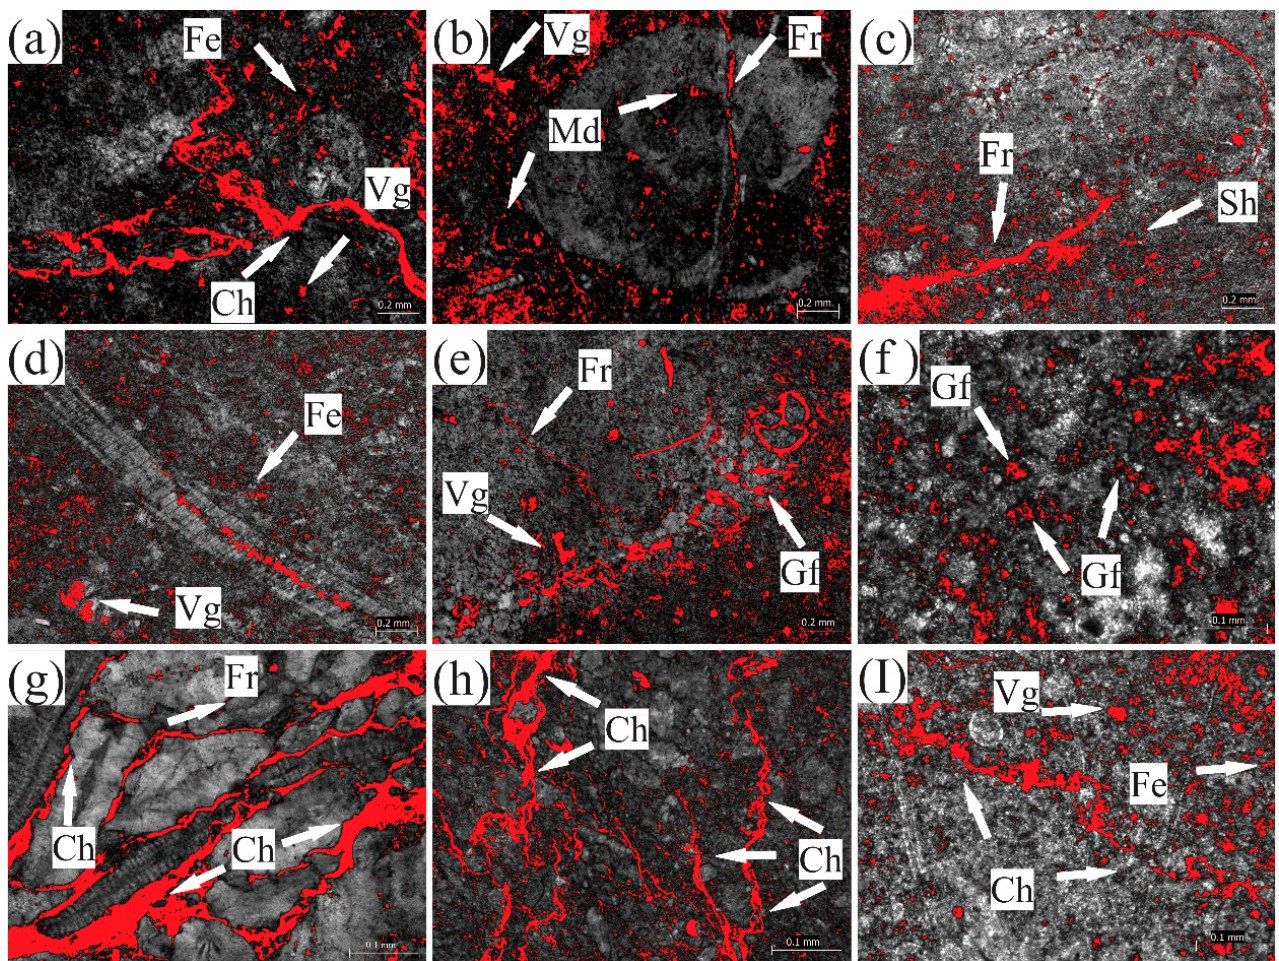
Figure 17. The image threshold enhancement technique in Image J software calculates porosity and reveals pore type for all microfacies of the Early–Middle Eocene rocks. ( a – I ) EMI, EMII, EMIII, EMIV, EMV, EMVI, EMVII, EMVIII, and EMVIX, respectively. Abbreviations of the porosity types shown in the figures: Fe, Fenestral; Ia, Intraparticle; Sh, Shelter; Vg, Vuggy; Ch, Channel; Gf, Growth Framework; Md, Moldic; and Fr, Fracture pore types.